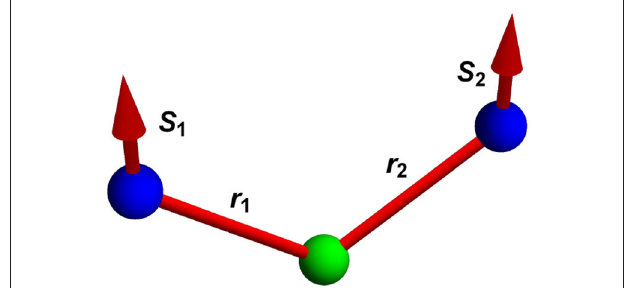
FIGURE 2 | Interaction between two neighboring spins is mediated by the non-magnetic atom. The direction of DMI vector resulting from such interaction is defined by the bond vectors, i.e., D 12